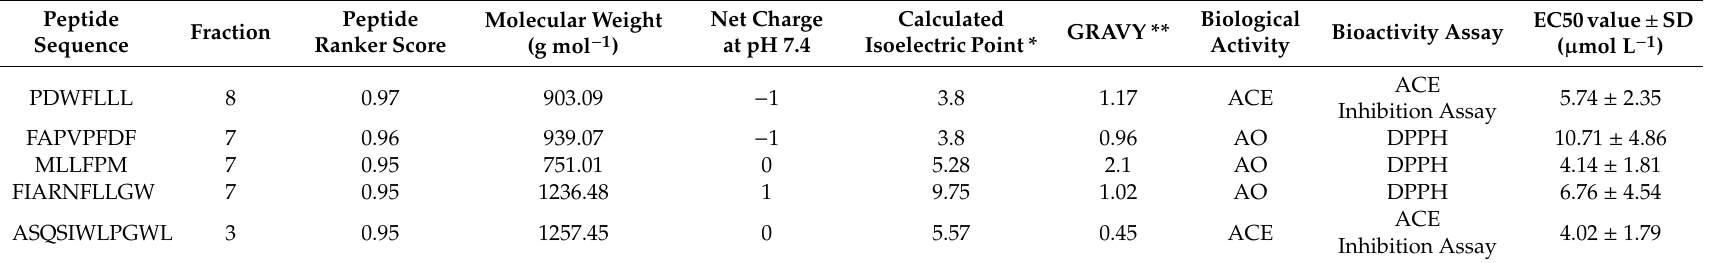
Table 1. Synthesized peptide sequences derived from asparagus by-products Alcalase hydrolysate and their